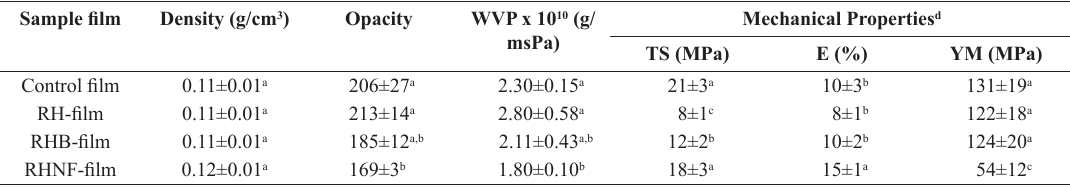
Table 1. Density, opacity, water vapor permeability (WVP) and mechanical properties of starch-glycerol films reinforced with RH, RHB and RHNF1h. Sample